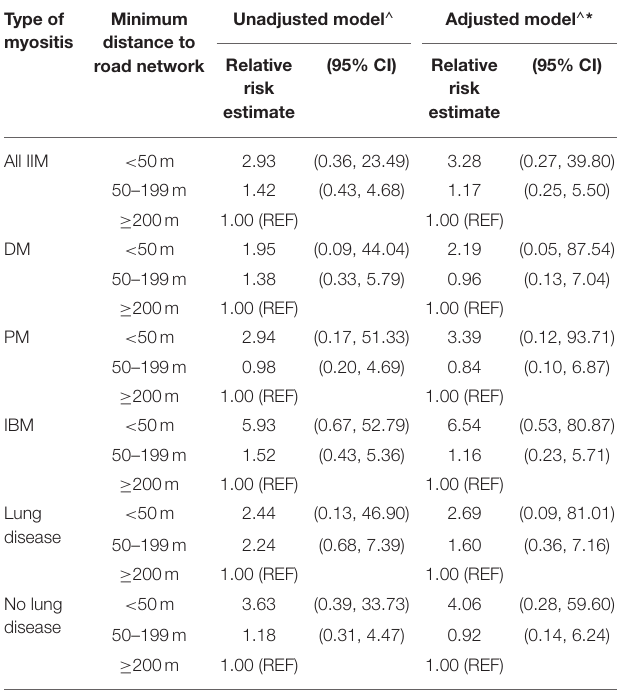
TABLE 2 | The unadjusted and adjusted relative risk estimates (with 95% CI) of the minimum distance from the residential location at diagnosis to major or minor road networks of developing IIM (from the log-Gaussian Cox process (LGCP) model). Type of